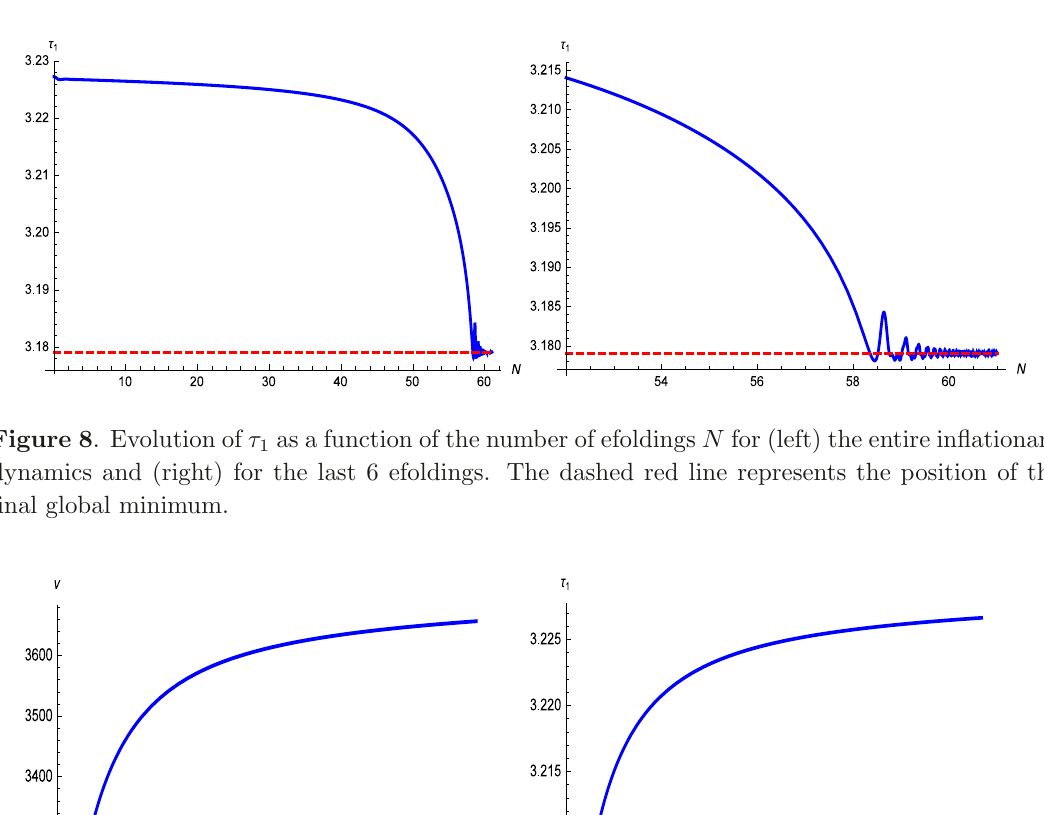
7 , V )-plane (on the left) and in the